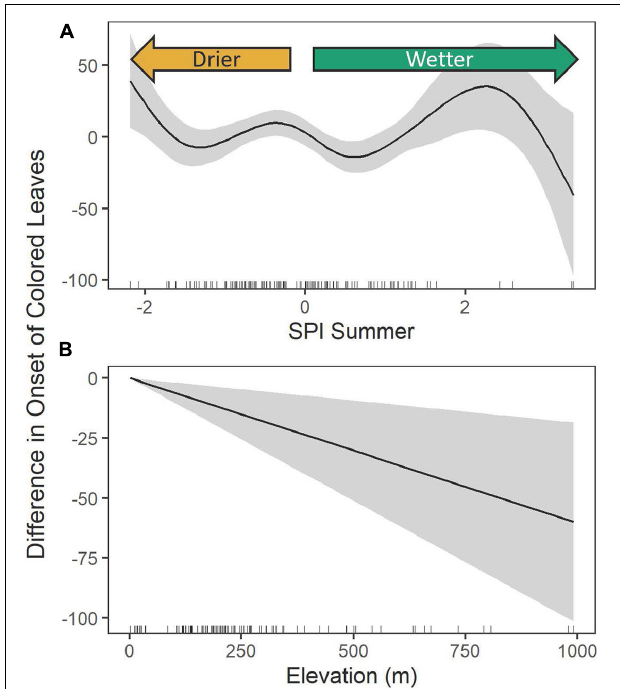
FIGURE 5 | The estimated contributions of the Summer SPI (A) and the elevation (B) for the General Additive Model of onset of colored leaves. The solid curve is the estimated contribution while the gray regions represent the 95% confidence interval, tick marks along the x-axis indicate the density of